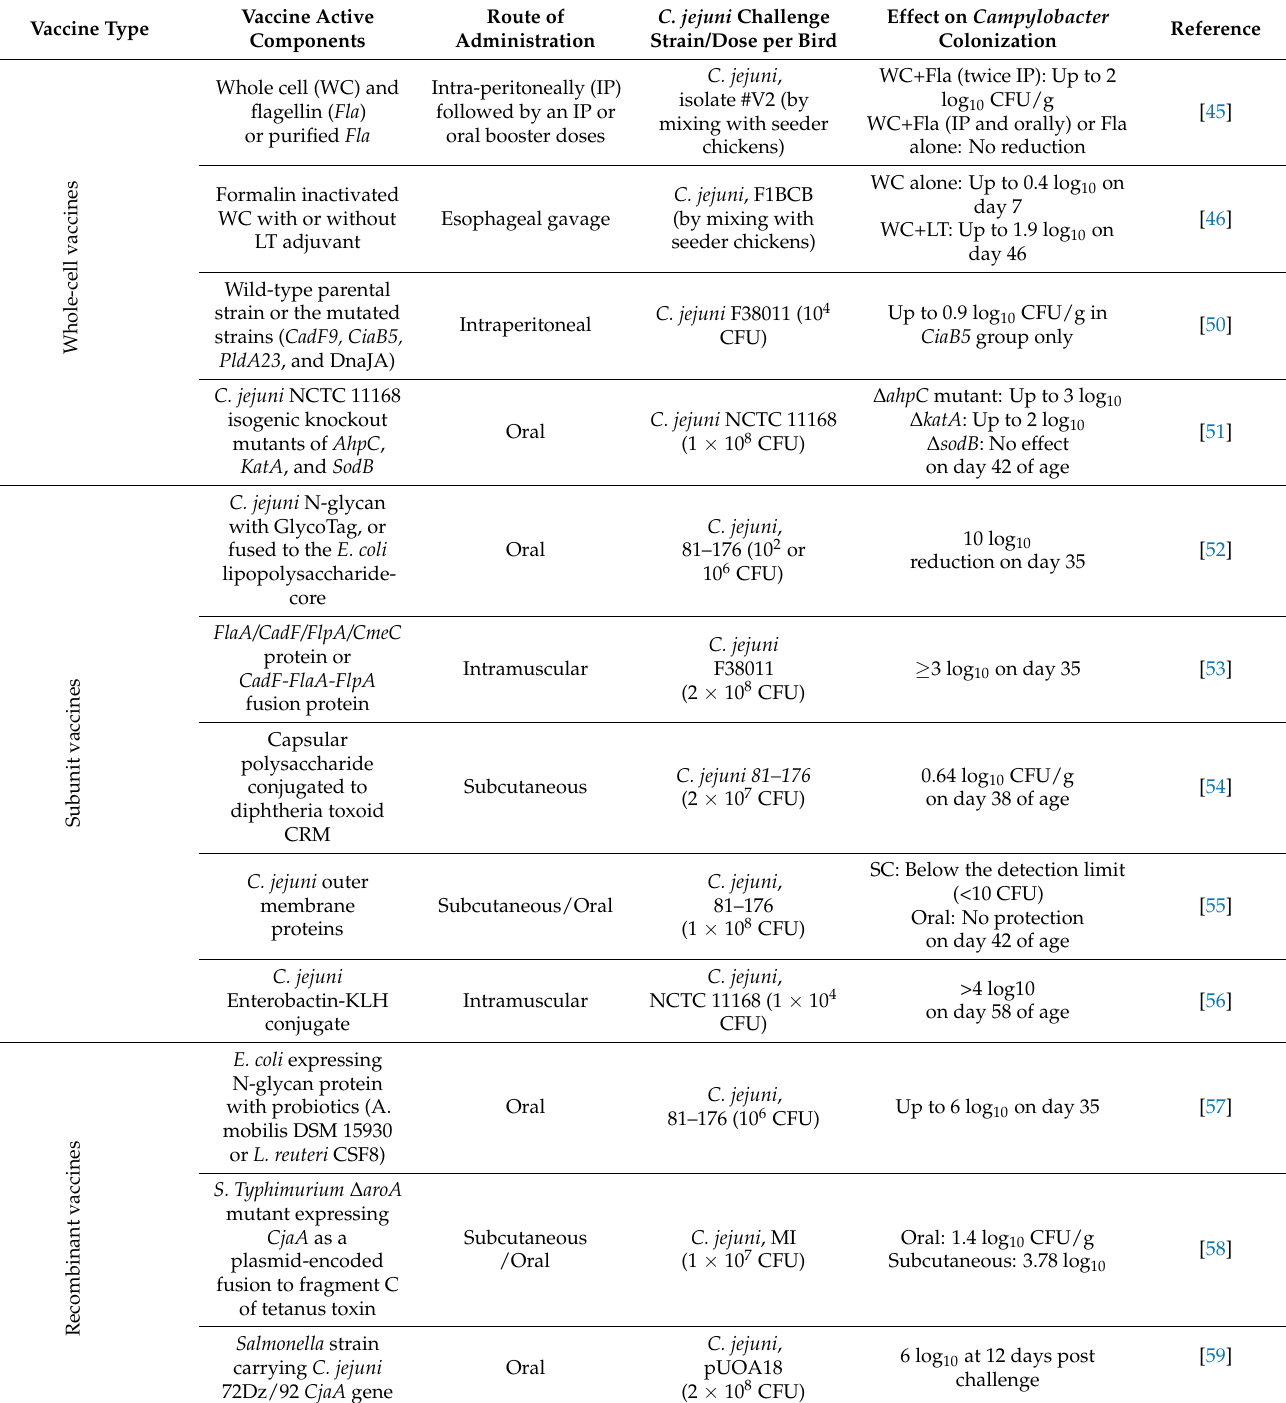
Table 1. Vaccination trials for C. jejuni infection in poultry (modified from